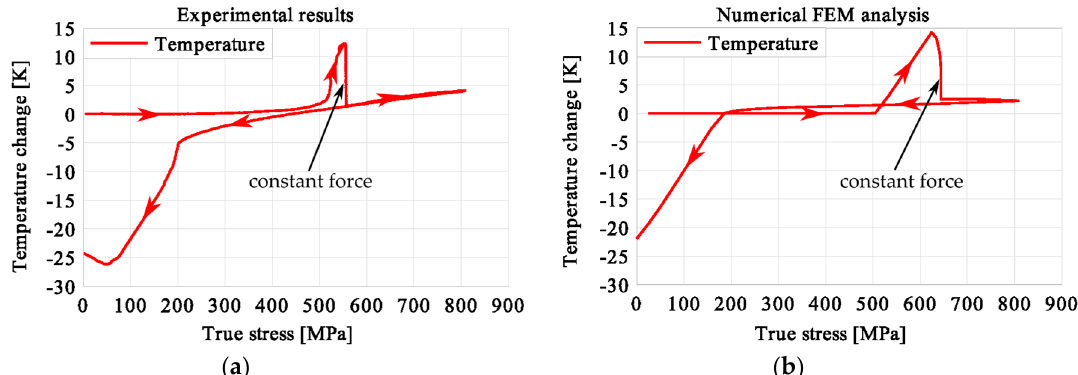
Figure 16. Temperature variations vs. stress for the loading program (3): 3-min loading interruption at the beginning of the LMT: ( a ) experimental; ( b ) numerical results.